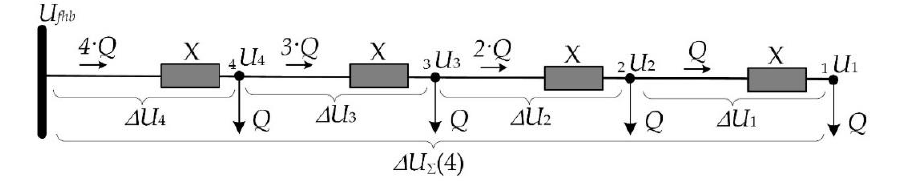
Figure A4. Equivalent circuit of the fourth term of (10).